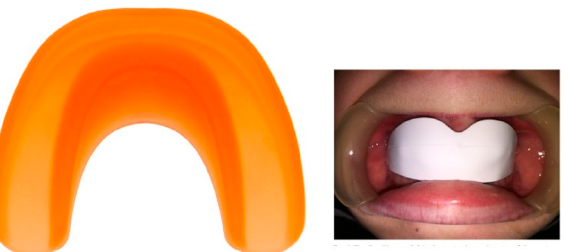
Figure 1. The Equilibrator Eptamed C3P orange and the Equilibrator C3P white in the oral cavity of the patient.